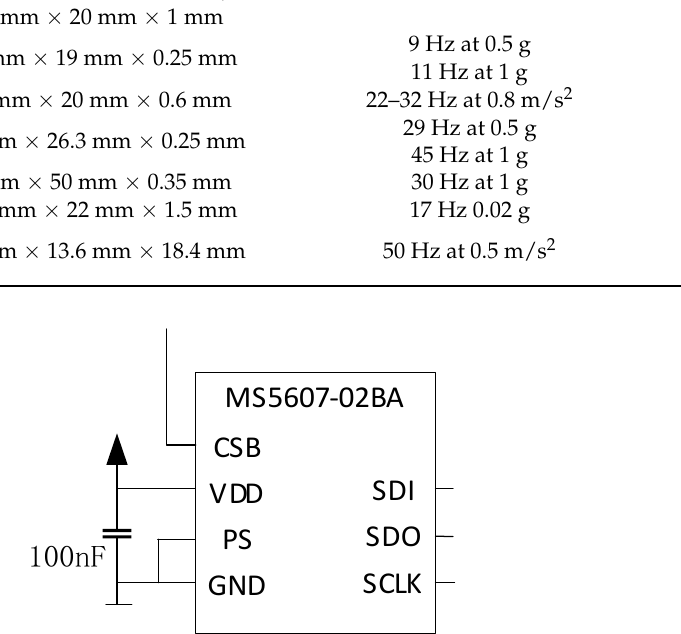
Figure 12. Typical application circuit of MS5607 barometric pressure sensor. The VDD and GND pins of the pressure sensor MS5607 were connected to the load end of the MSI-SECEE circuit. The resistance in parallel with 100 k Ω was used as the matching resistance. The output signal of the SDO pin was displayed by an oscilloscope in real time. By observing the duty ratio of the square wave signal output by the SDO pin of the pressure sensor, we judged whether the energy output by the MSI-SECEE circuit can cause the pressure sensor to work properly in the vibration environment. As shown in Figure 13a, the pressure sensor output a square wave signal with a stable duty cycle when the ambient pressure was stable. In the experiment, the ambient pressure was changed artificially (Figure 13b). The duty cycle of the square wave output by SDO changed and the middle vacancy part corresponded to the signal change after the pressure changes.